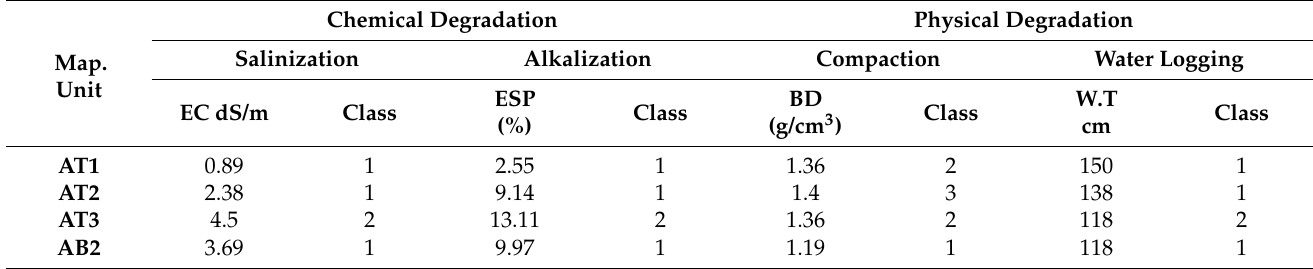
Table 4. Soil degradation degrees in the different mapping